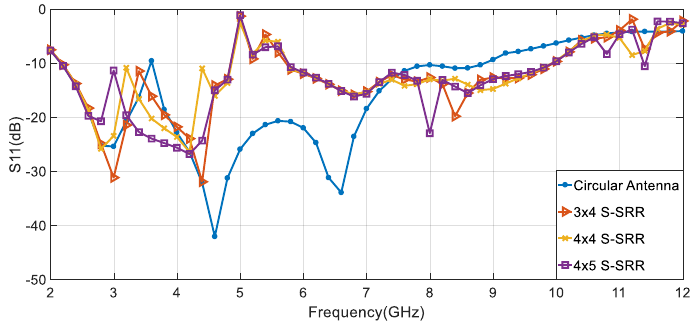
Figure 43. S 11 for 3 × 4, 4 × 4 and 4 × 5 S-SRR.